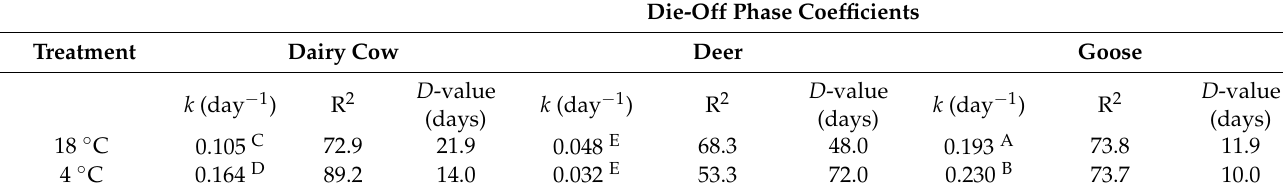
Table 1. Linear model parameter values for E. coli decay in sediment contaminated with differ- ent faecal types; superscript letters indicate grouping information for k using Tukey’s pairwise comparisons. Die-Off Phase